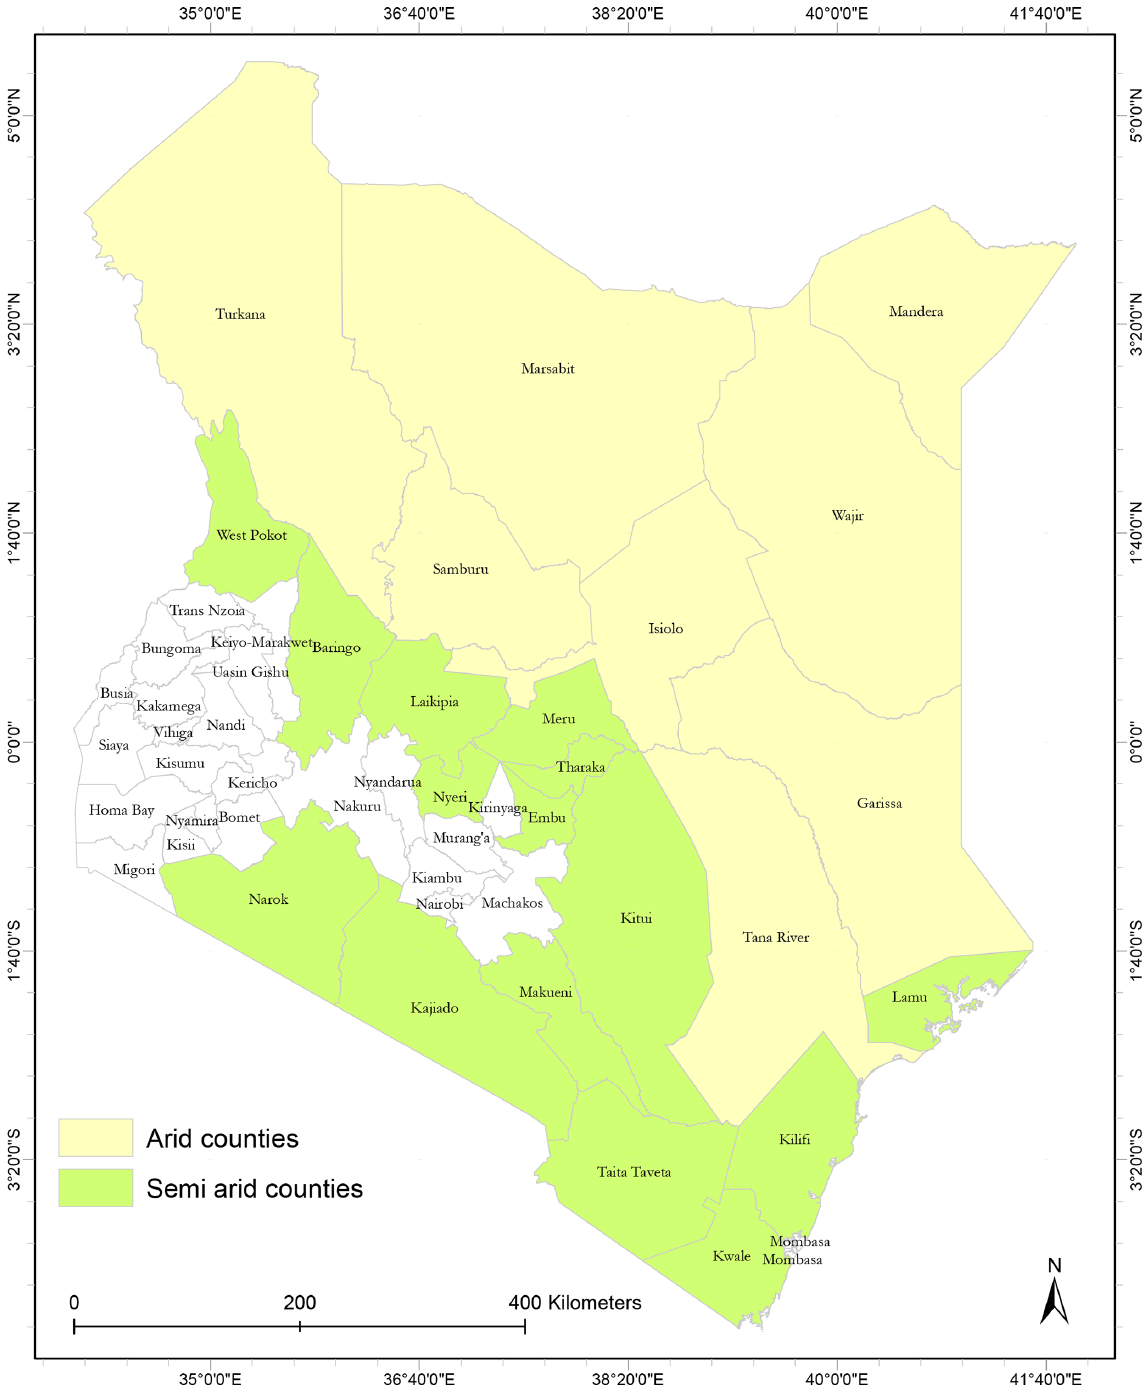
Figure 1. A map of Kenya showing the arid and semi-arid counties where the research was focused. Data were sampled from 8 arid and 12 semi-arid